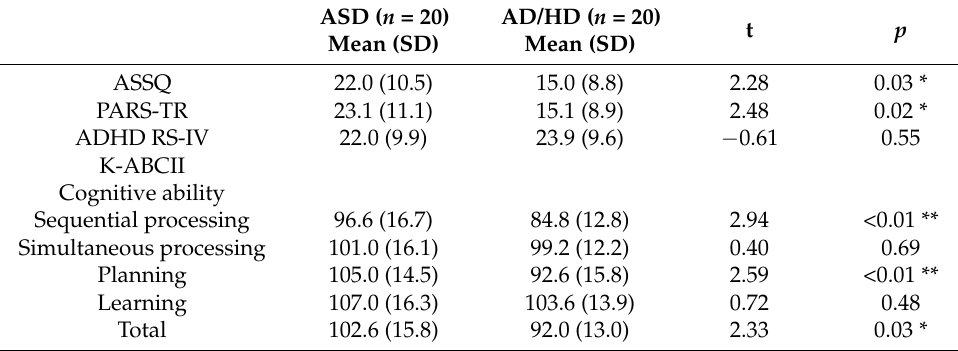
Table 1. Comparison of scores for questionnaire and K-ABCII between the ASD group and AD/HD